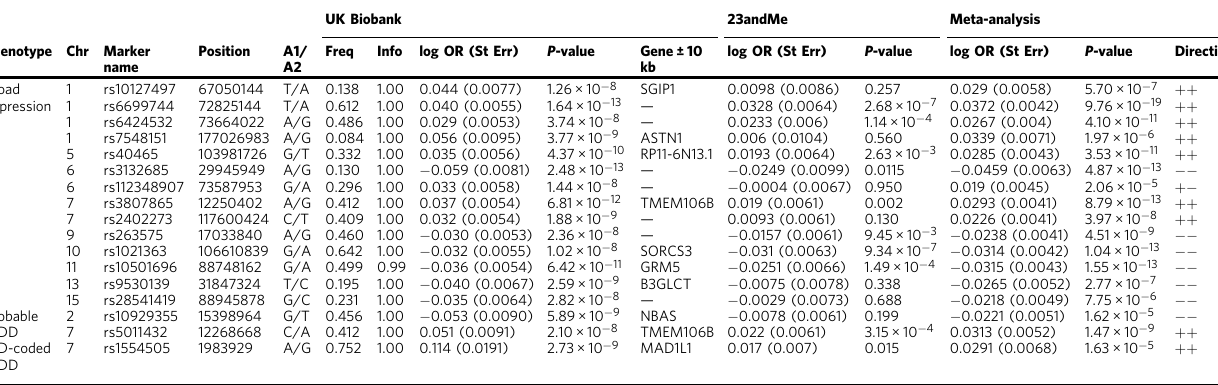
Table 1 Independent variants with a genome-wide signi fi cant ( P < 5 × 10 − 8 ) association with broad depression, probable major depressive disorder (MDD), or International Classi fi cation of Diseases (ICD)-coded MDD in the UK Biobank UK Biobank